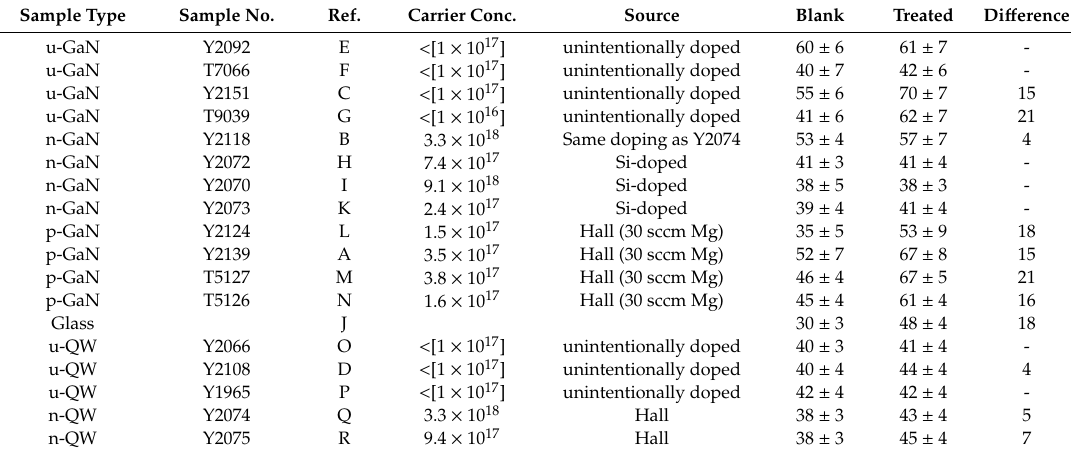
Table 2. Mean fluorescence intensity (a.u.) of biomolecule functionalized substrates. Mean value ± standard deviations are reported, sccm: standard cubic centimeters per minute. Conc. In bracket means assumed concentration in cm –3 .